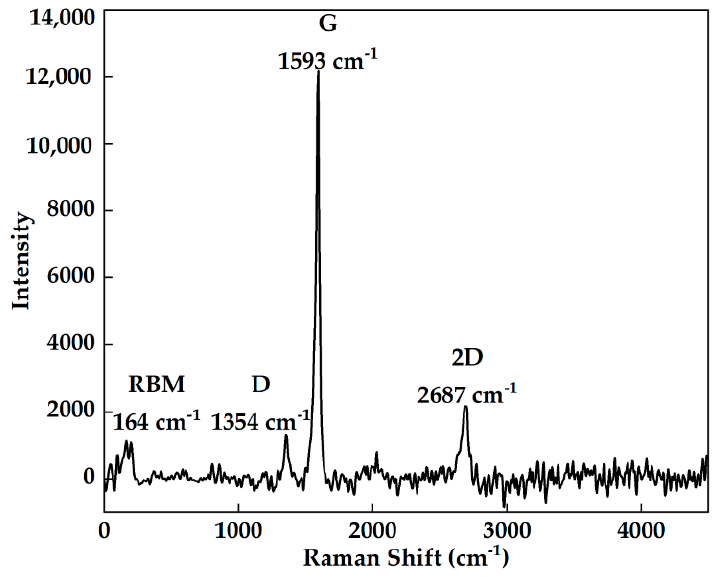
Figure 2. Raman spectrum of CNT ‐ chitin film.